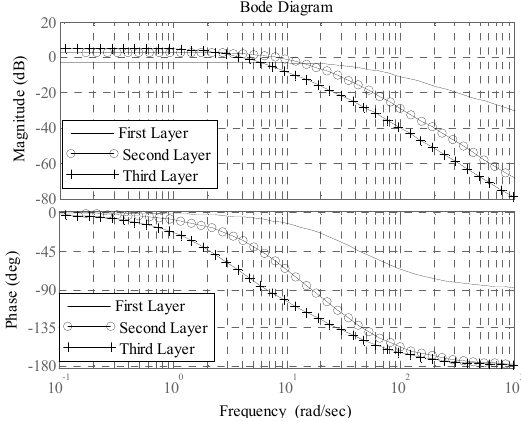
Fig.. 4: Bode diagram for the first, second and third layers. Fractional analysis of the general model in the Laplace space and general model for the equivalent electrical